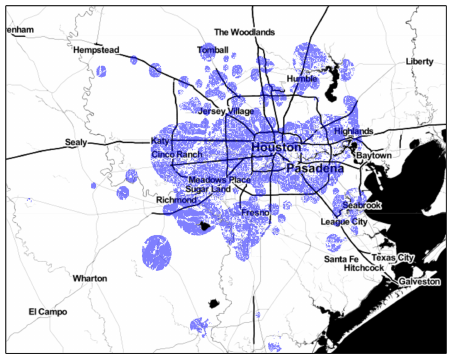
Figure 3. Support obtained for the polygon stacking spatial information extraction with w (in blue). The map tiles are by Stamen Design. Table 1. Support and imbalance for the tested spatial information extraction